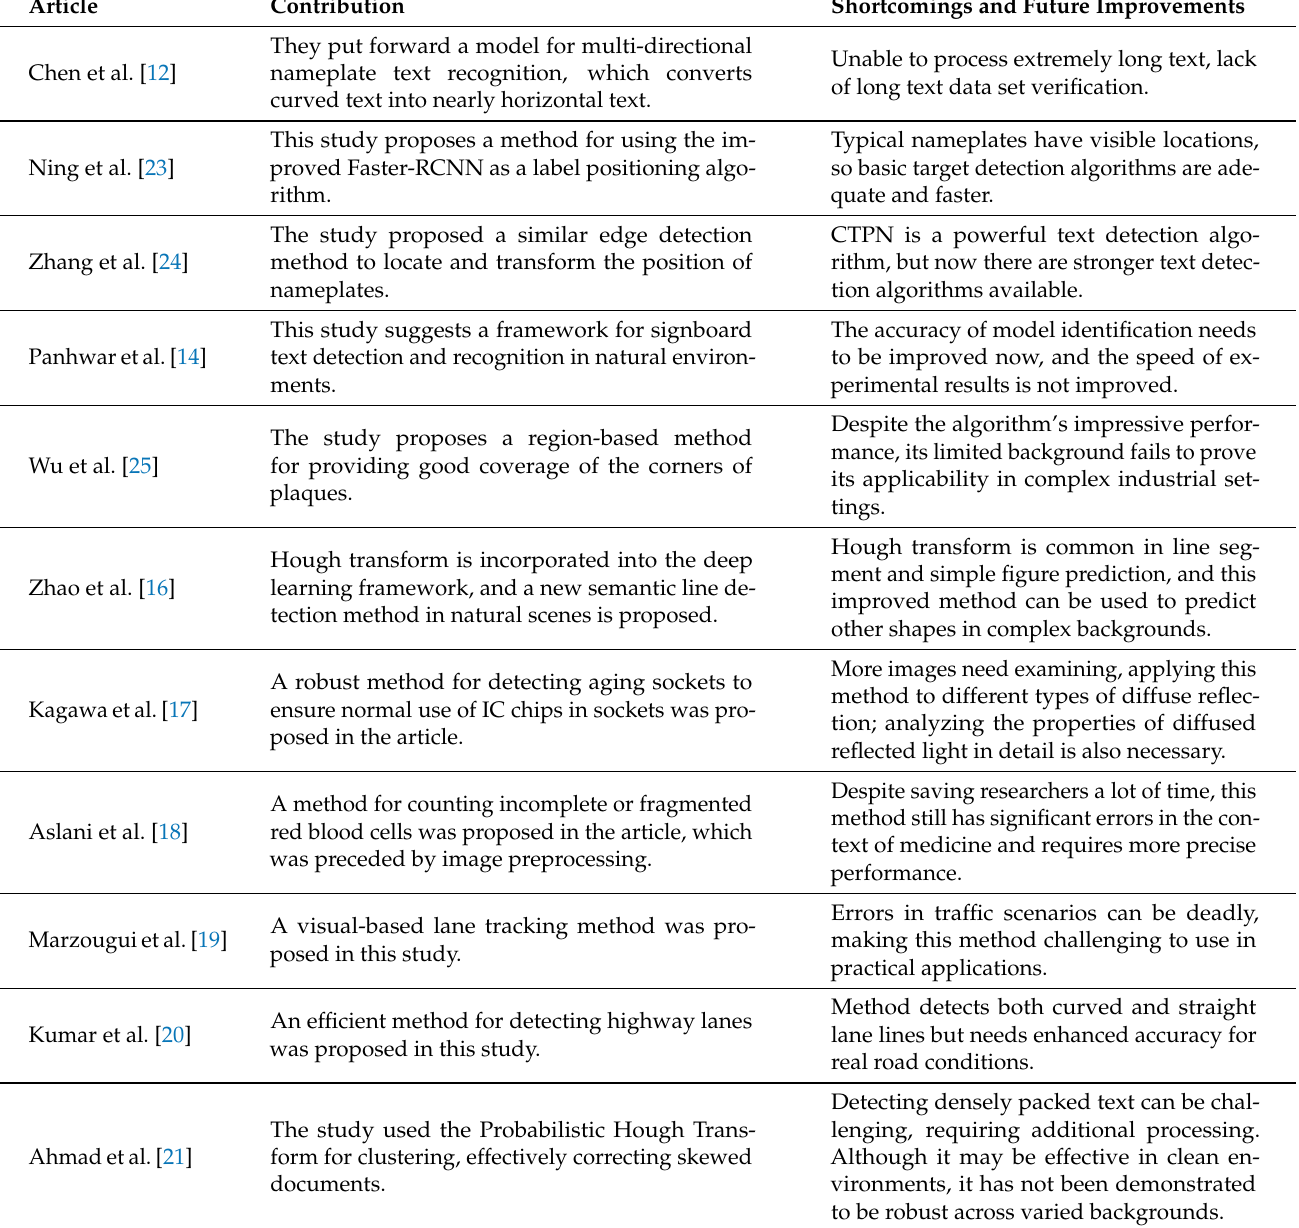
Table 1. Contributions and improvements from related